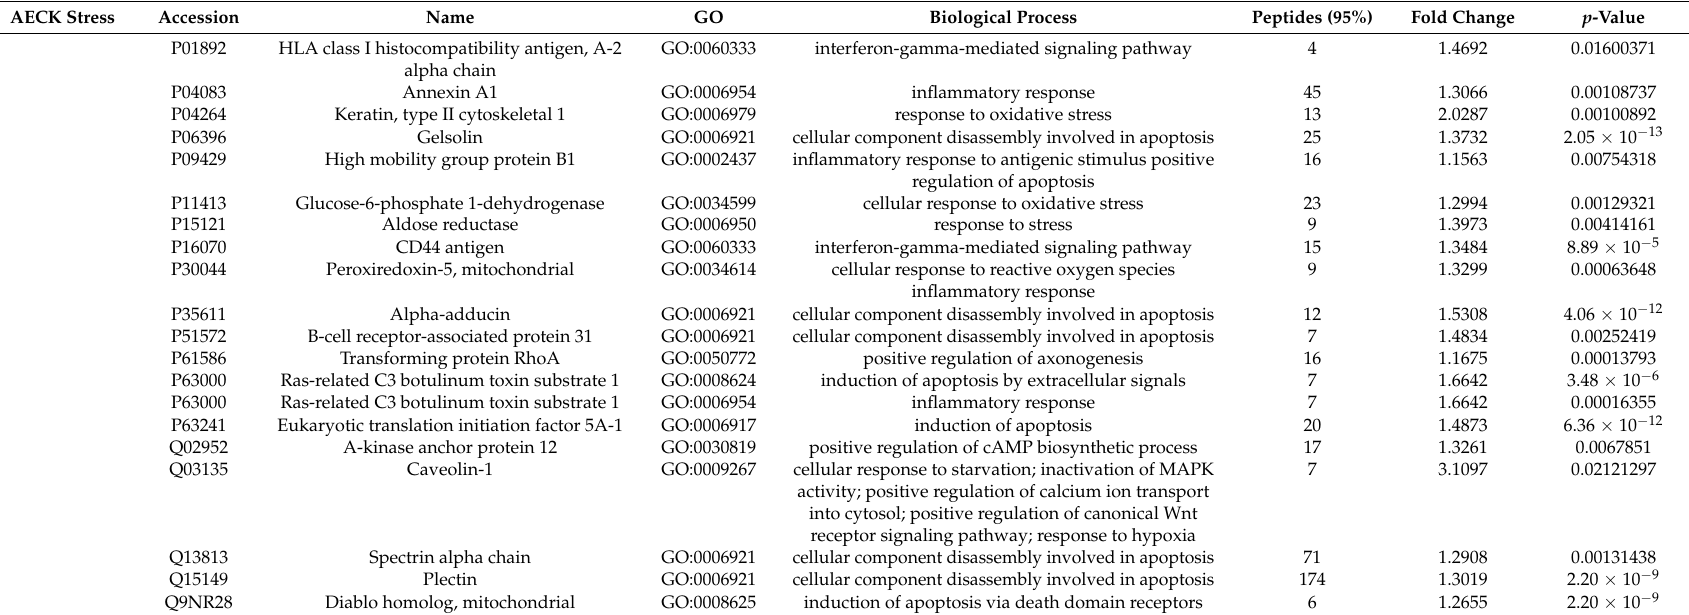
Table 4. Summary of significant up-regulated stress-related proteins identified in iTRAQ of hADSCs treated with AECK. AECK Stress